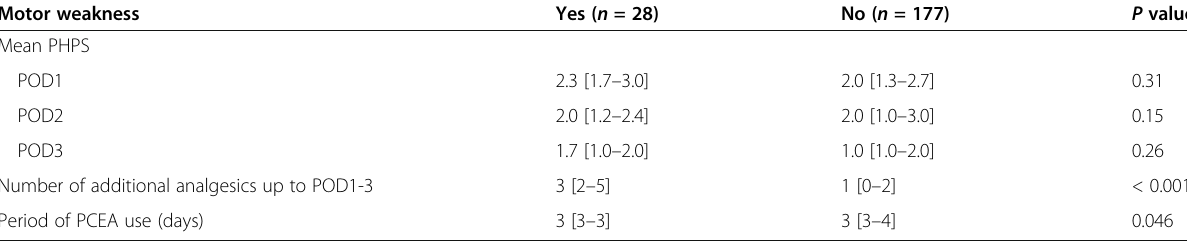
Table 3 Motor weakness in the lower extremities and analgesic effects Motor